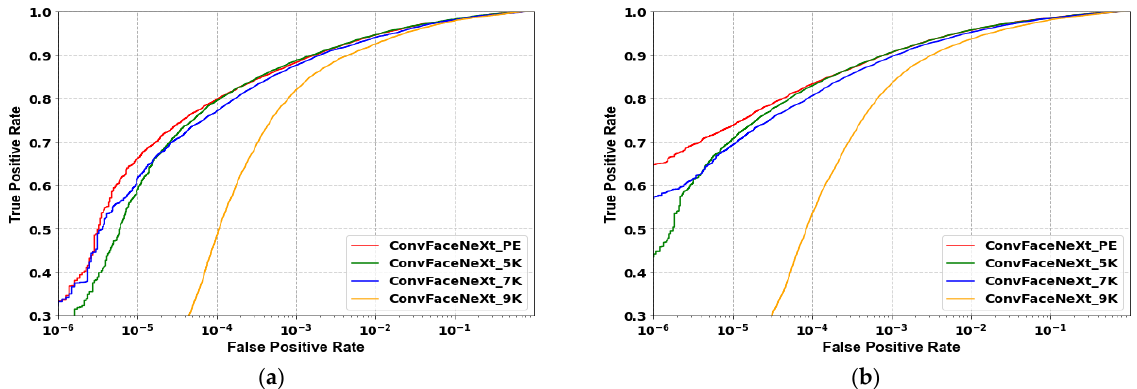
Figure 5. ROC curves of 1:1 verification for different kernel sizes. ( a ) IJB-B dataset. ( b ) IJB-C